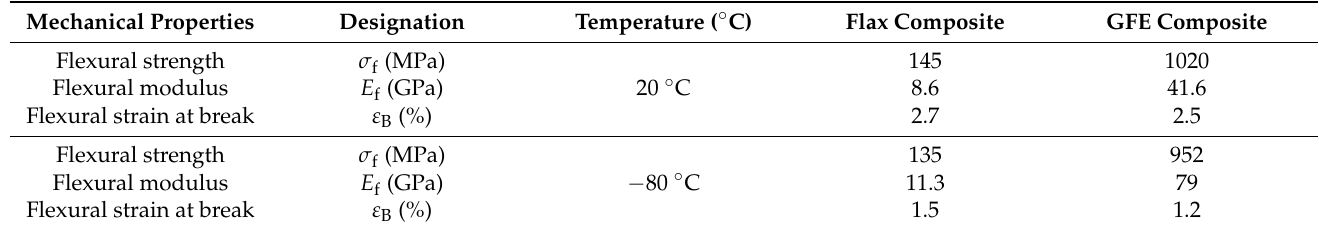
Table 3. Flexural properties of flax and GFE composites at room temperature and at − 80 ◦ C.